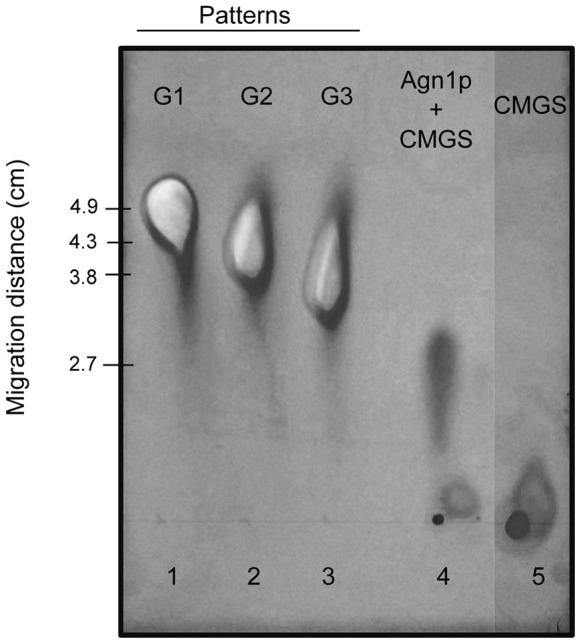
Thin Layer Chromatography (TLC).
P. brasiliensis Agn1p was incubated for 1 h with CMGS. Lanes: 1, glucose (G1); 2, maltose (G2); 3, maltotriose (G3); 4, Agn1p incubated with GMGS; 5, CMGS.